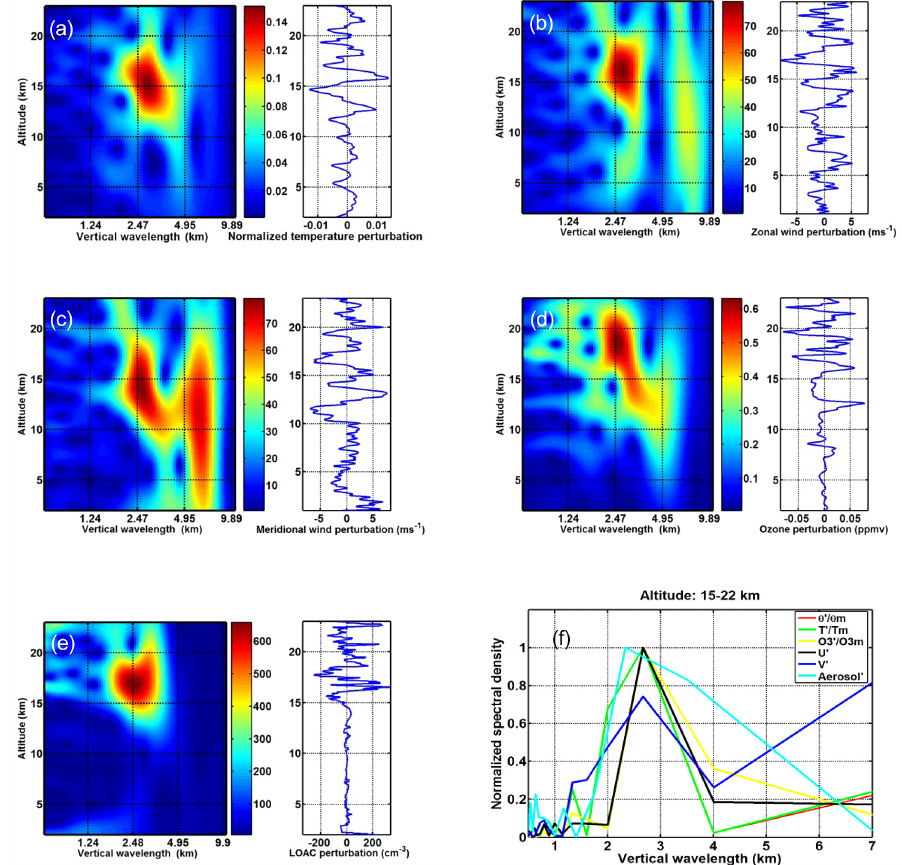
Figure 4. Morlet CWT of perturbations expressed as physical unit 2 km − 1 (left panels): (a) normalised potential temperature, (b, c) horizontal wind components u and v (ms − 1 ) , respectively, and (d) ozone concentration in units of parts per million by volume (ppmv) and (e) aerosol concentration (cm − 3 ) of 0.2–0.7µm size classes. Perturbations are visualised on the right panels. Colour scale: red relatively high values, blue relatively low values. (f) Normalised fast Fourier transform of normalised potential temperature, normalised temperature, horizontal wind (ms − 1 ) and ozone (ppmv) and aerosol concentration (cm − 3 ) perturbations at heights of